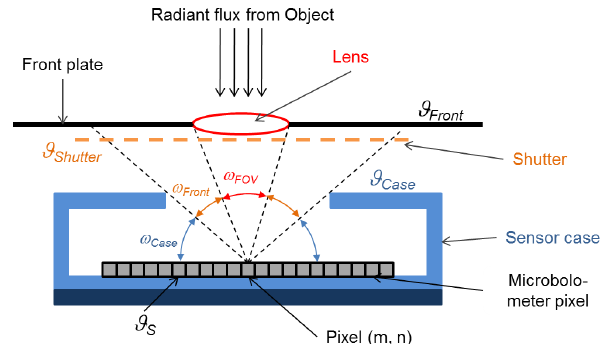
Figure 2. Optical channel in an uncooled IR camera. ω x : reduced solid angles; ϑ x : temperatures.